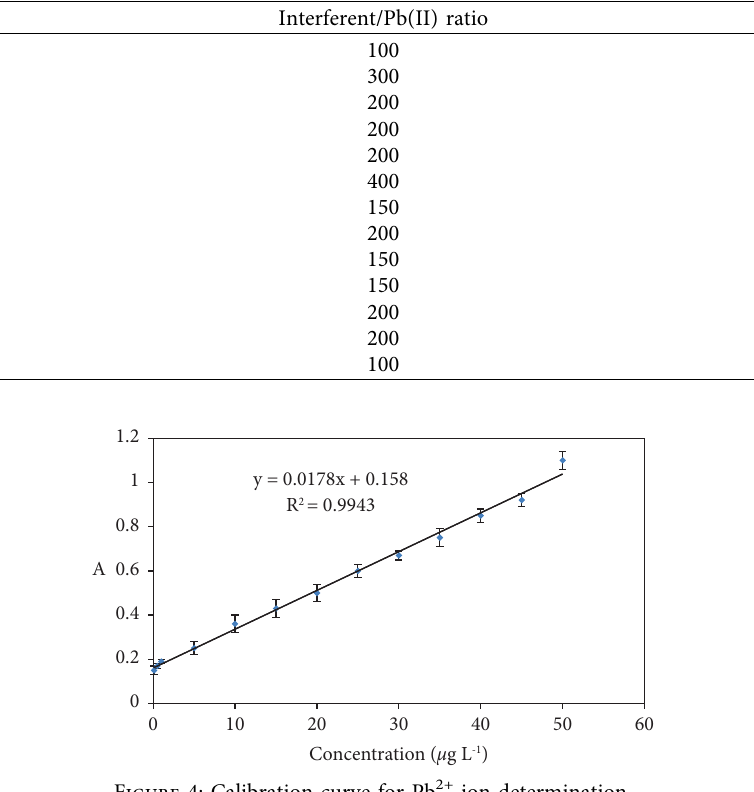
Table 2: Efect of interfering ions in the presence of 10 μ g · L − 1 lead.